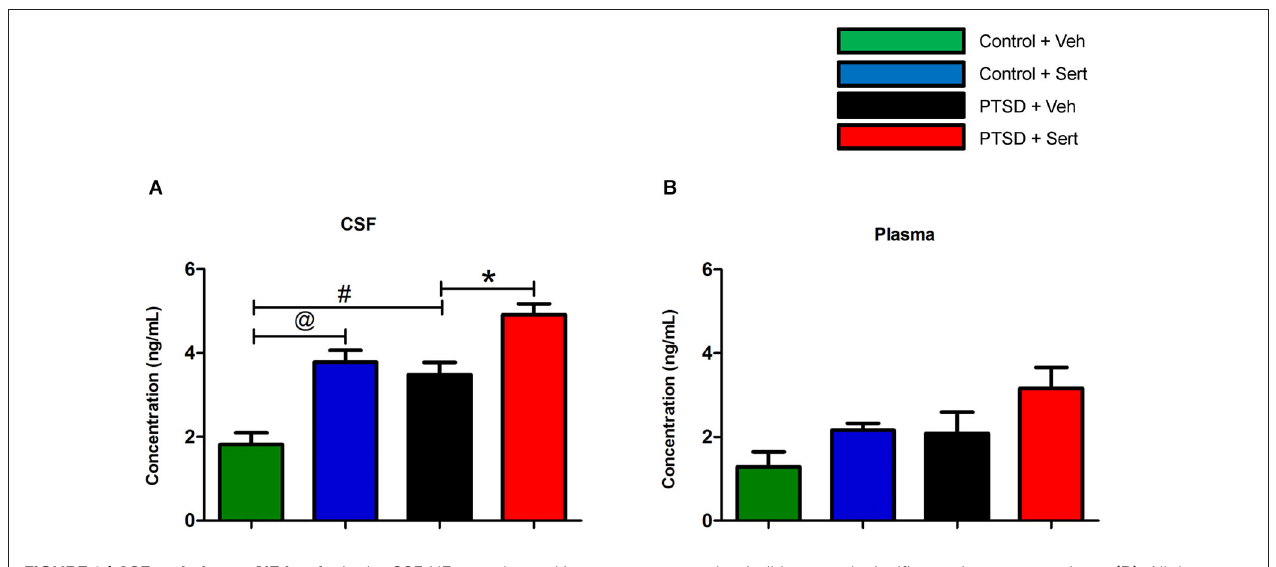
FIGURE 3 | CSF and plasma NE levels. In the CSF, NE was elevated in the PTSD + Veh vs. the control + Veh group and in the control + Sert vs. the control + Veh group. NE was further elevated in the PTSD + Sert vs. the PTSD + Veh group (A) . In the plasma, NE was higher in the treatment